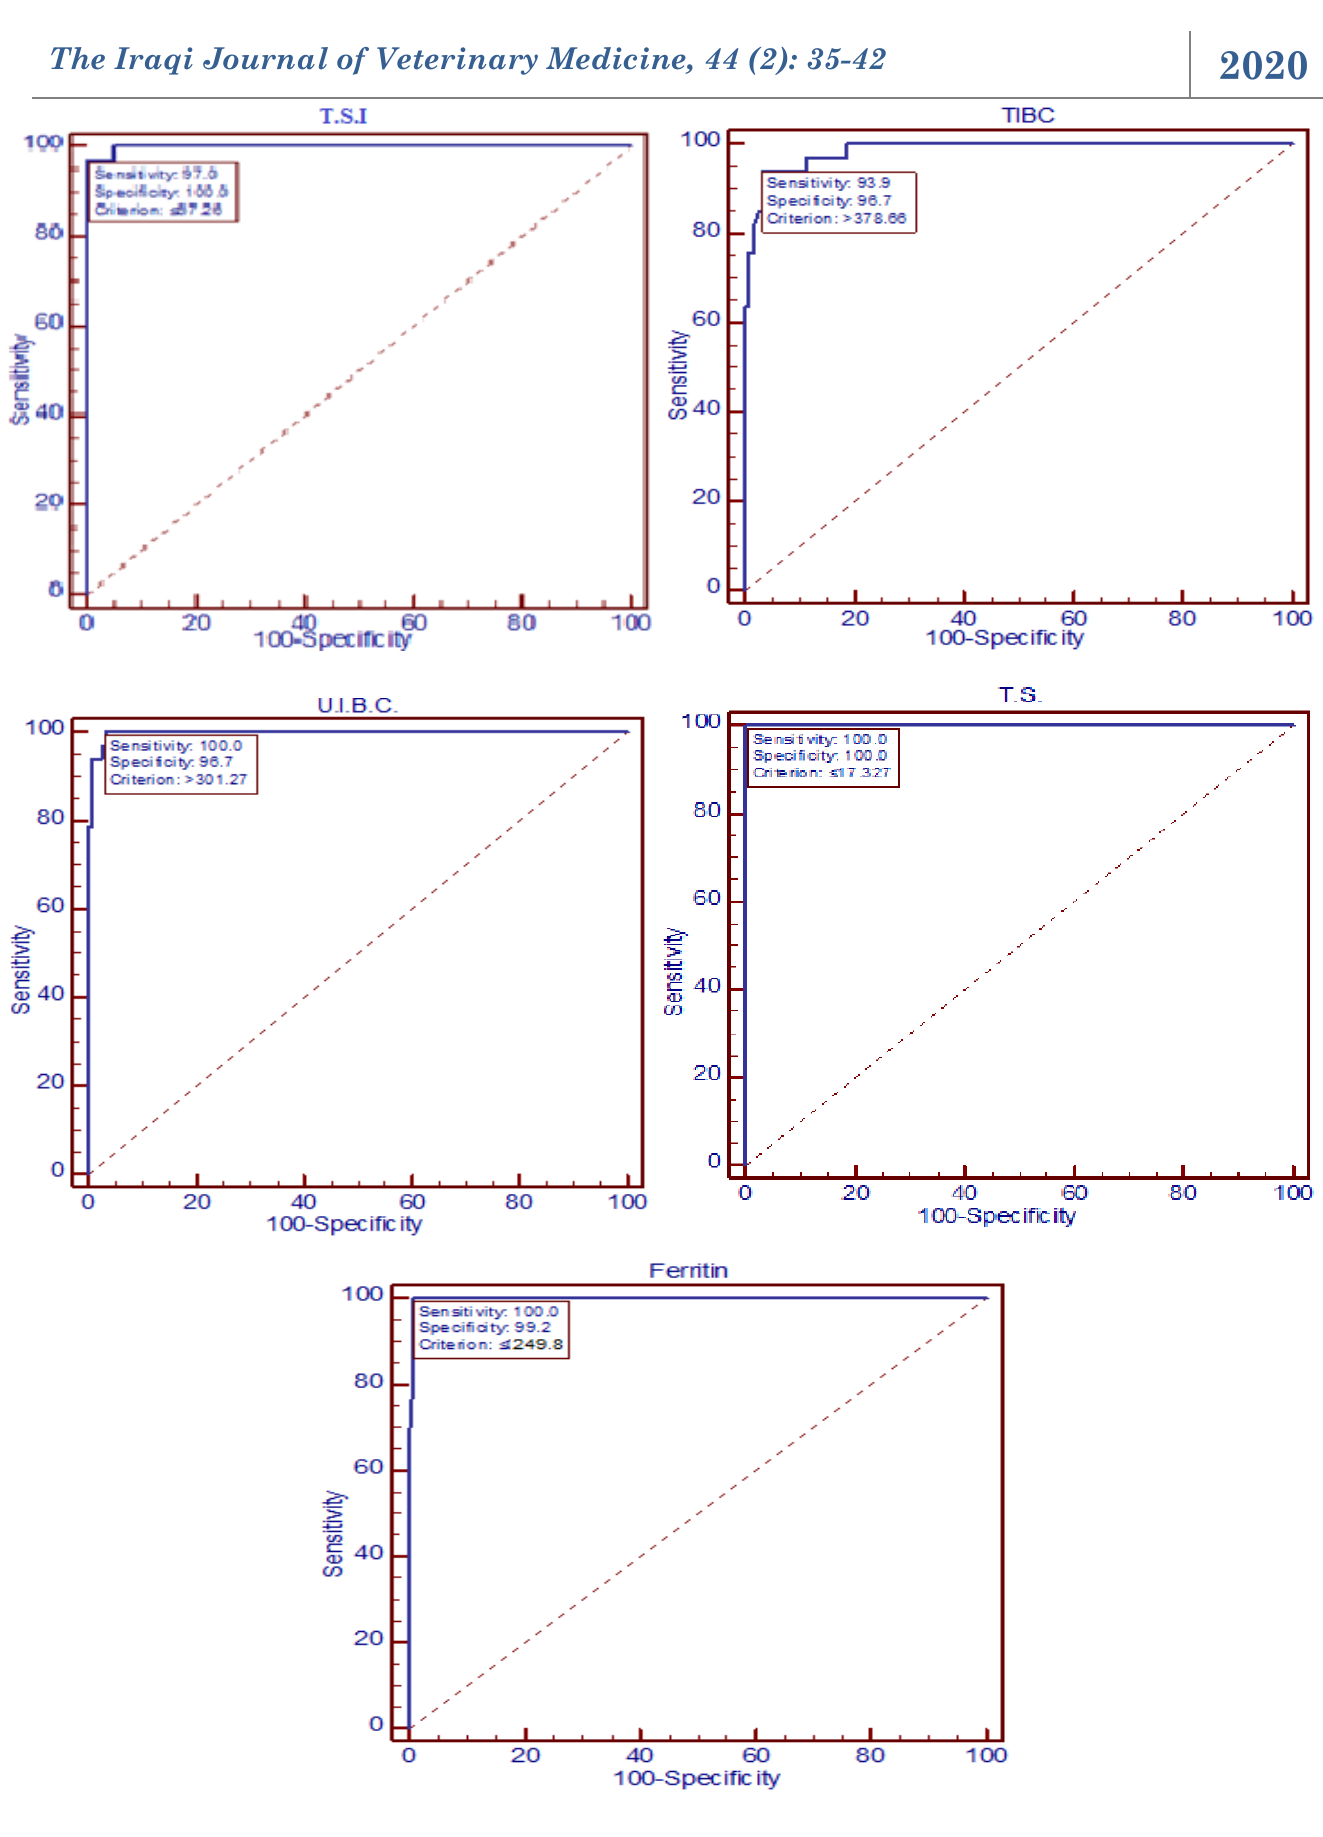
Figure 5. Cutoff point test with present Sensitivity and Specificity for iron status